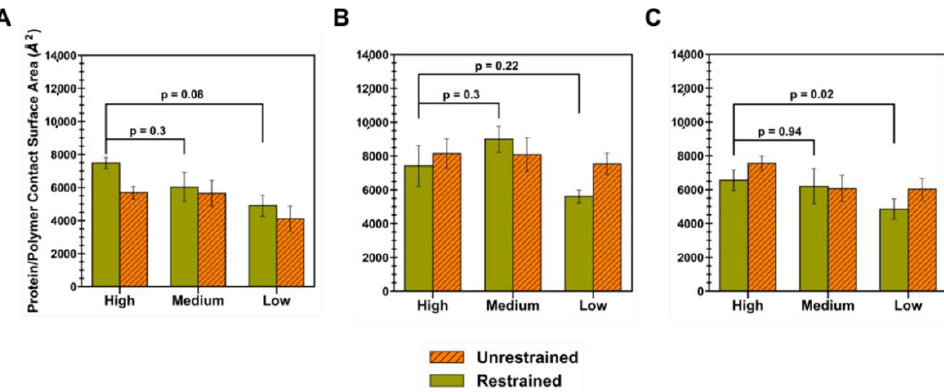
Figure 6. Protein–polymer contact surface area (CSA) at each level of extension for ( A ) PLGA/ID2S, ( B ) PEG/ID2S, and ( C ) PLGA-PEG/ID2S. Mean values and their respective SE came from averaging CSA values of the protein–polymer interface across simulation trials (n = 7). Statistical significance was evaluated using the Wilcoxon signed-rank test, a non-parametric version of the paired T-test that does not assume a normal distribution.